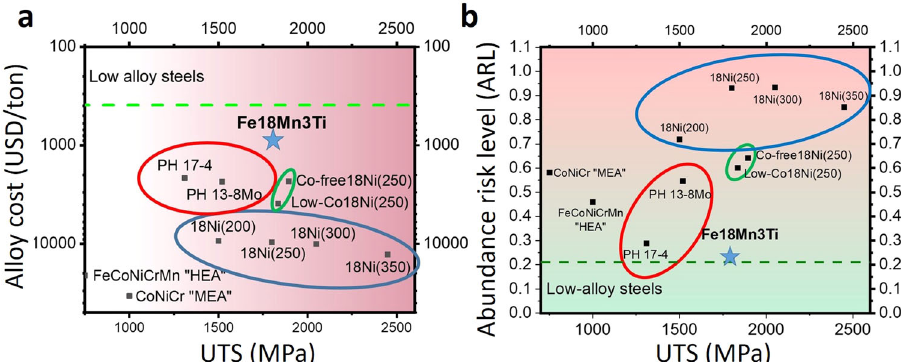
Fig. 6 Potential for application. a Alloy cost comparison and ( b ) abundance risk level (ARL) of different precipitation hardened ultra-high strenght